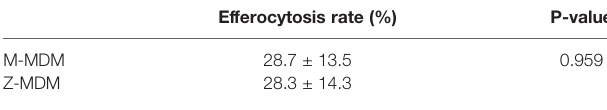
TABLE 3 | The efferocytosis rate of M- and